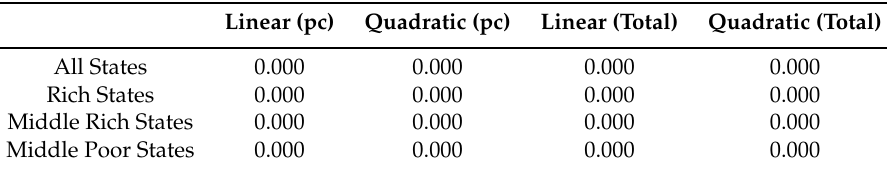
Table 2. p -values of the linear and quadratic